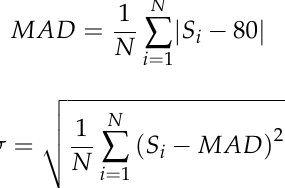
Table 3. Statistical analysis of measurement errors for the three methods.